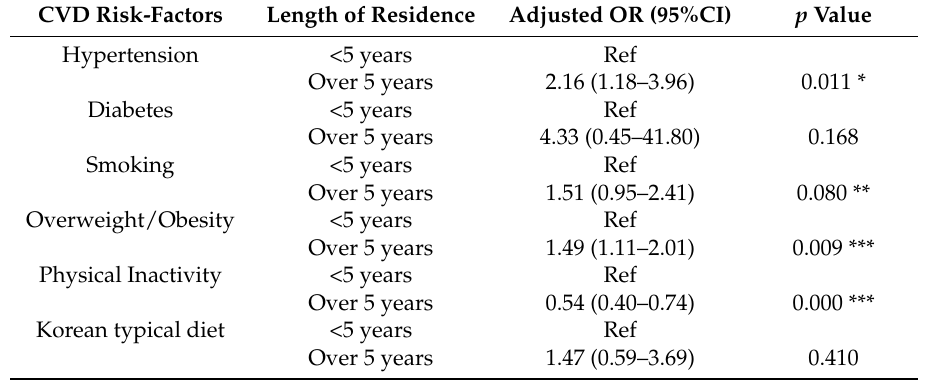
Table 4. Multivariate logistic regression: association between length of residence and CVD risk